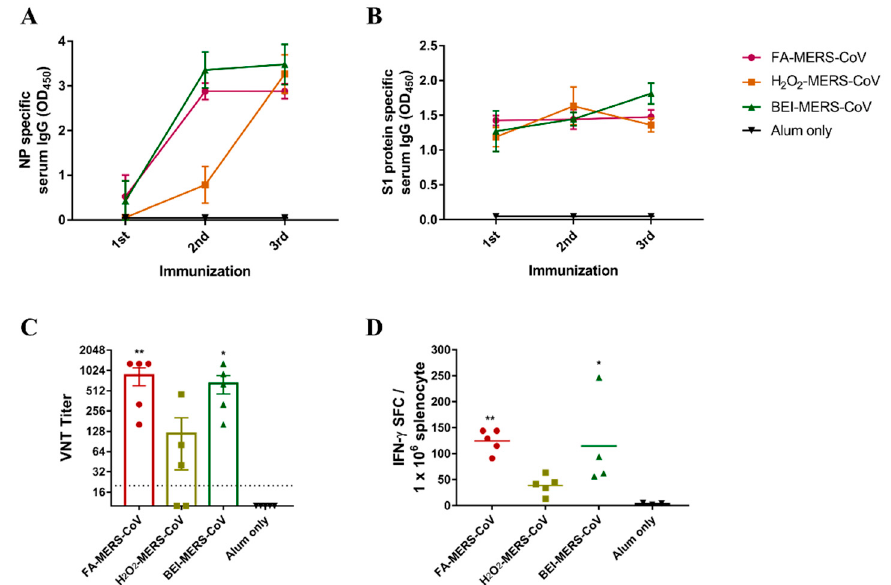
Figure 1. Inactivated MERS-CoV induced humoral/cellular immune responses in C57BL/6 mice. MERS-CoV nucleocapsid protein ( A ) and S1 protein-specific serum IgG ( B ) levels were measured by ELISA. Serum was collected after the first, second, and third immunization at two-week intervals. ( C ) MERS-CoV specific neutralizing antibodies (nAbs) were determined by virus-neutralizing titers (VNT). Serum was collected two weeks after the third immunization. ( D ) IFN- γ secreting T-cell were quantified by ELISPOT. The splenocytes from last immunized mice were stimulated with inactivated- MERS-CoV. Data are represented as the mean ± S.E.M. * p < 0.05, ** p < 0.01 compared with alum